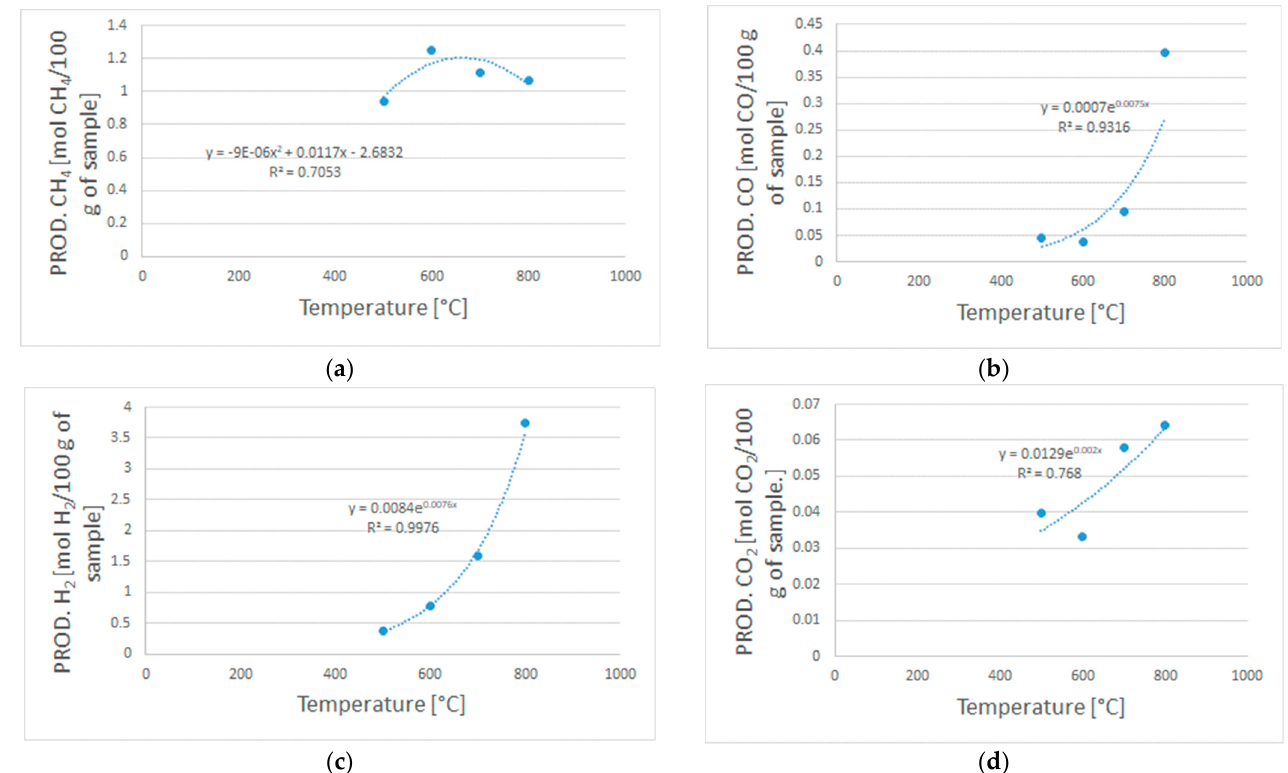
Figure B1. Polynomial equation ( a ) used to model the CH 4 productivity, and exponential equations ( b – d ) used to model the H 2 , CO, and CO 2 productivity.